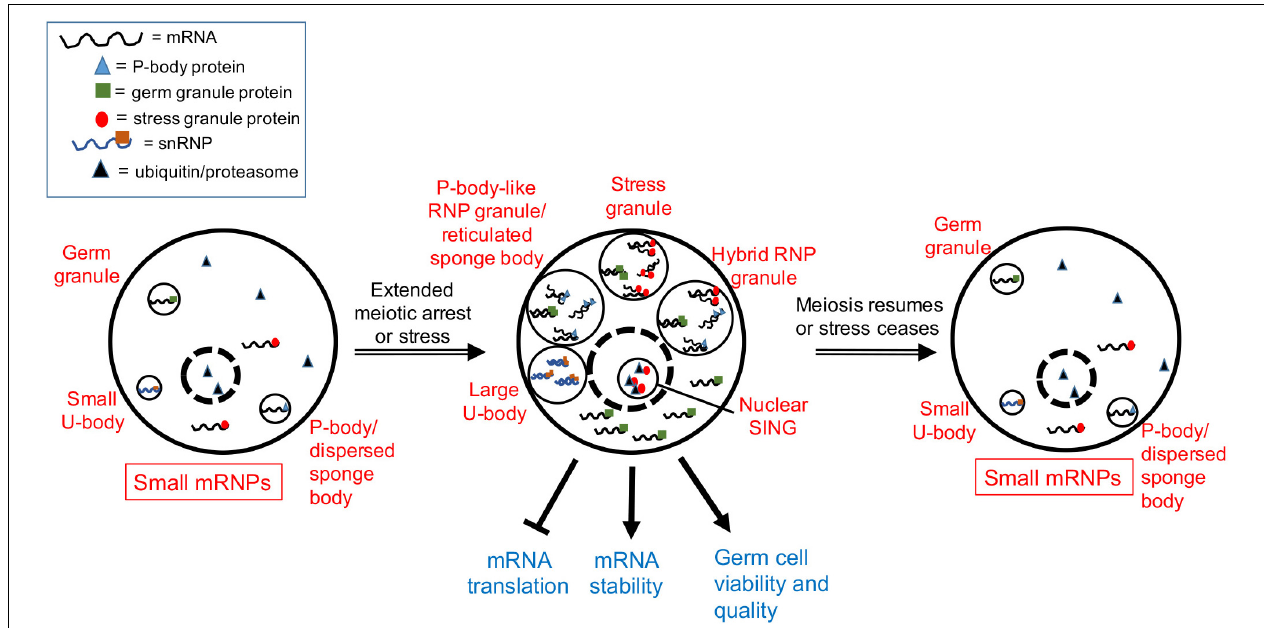
FIGURE 1 | Model showing a composite of RNP granule stress responses during gametogenesis. Depending on the organism and the type of stress (see text), one or more of the five responses can occur in germ cells. Dashed circle is the nucleus. Stress granules assemble in heat-stressed mouse spermatocytes. Hybrid RNP granules form in the Caenorhabditis elegans germ line and contain germ granule proteins, as well as P-body and stress granule proteins. P-body-like RNP granules, similar to reticulated sponge bodies, assemble in Drosophila egg chambers and lack stress granule markers. Large U bodies associate with P-bodies in stressed Drosophila oocytes. Nuclear SINGS are stress-induced nuclear granules in the C. elegans germ line that may represent localized protein